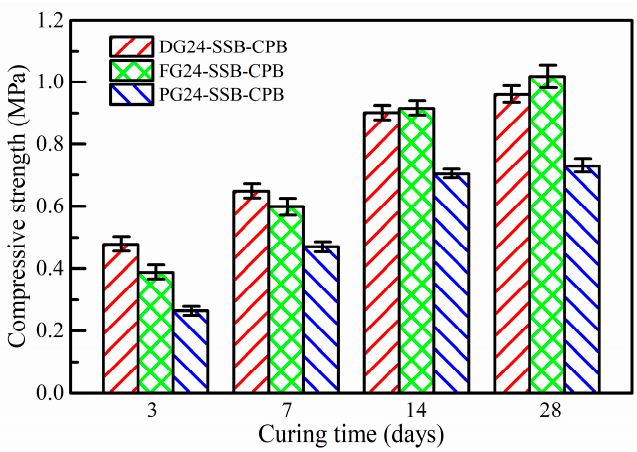
Figure 7. Strength of hardened SSB-CPB with di ff erent gypsums.